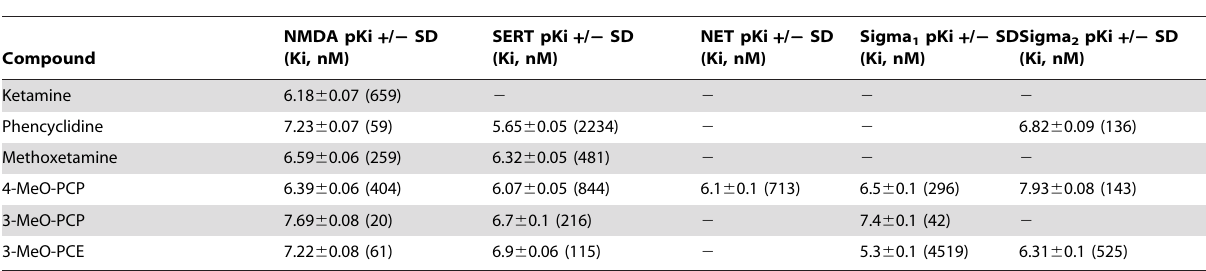
Table 2. Representative pKi values for ketamine, PCP and analogues.